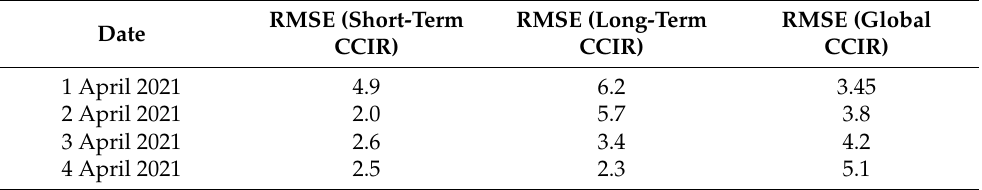
Figure 9. Output of the system under the testing phase with Cyprus Short (orange), Cyprus Long (red), and Global (green) CCIR options for ( a ) 1 April 2021, ( b ) 2 April 2021, ( c ) 3 April 2021, and ( d ) 4 April 2021. Table 1. RMSE values in TECU for each day in the interval 1–4 April 2021.